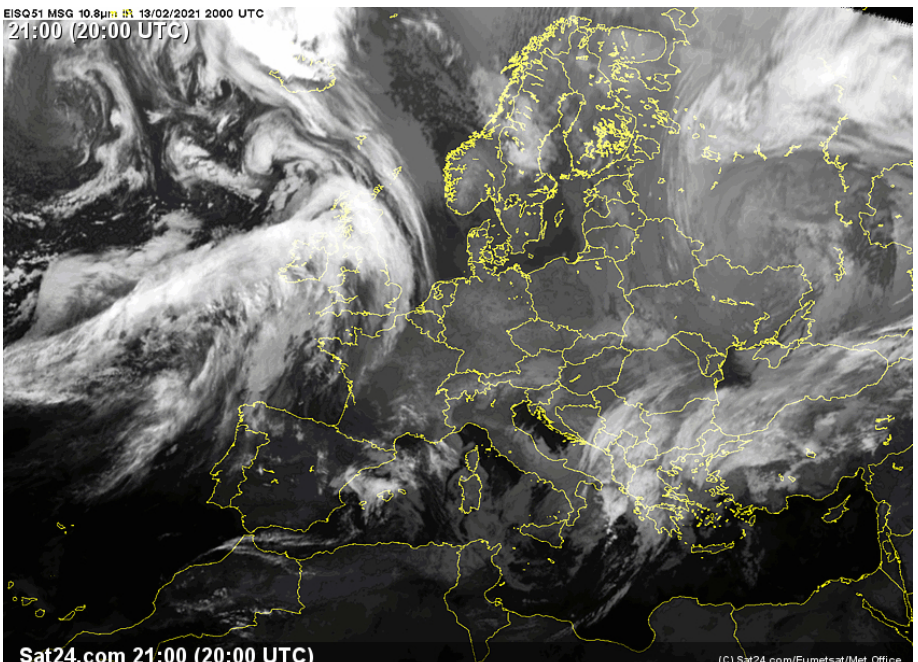
Figure 5. Infrared (10.8 µ m) satellite image from SAT24-EISQ51 over Europe on 13 February 20 UTC showing a clear sky over Switzerland and Germany.